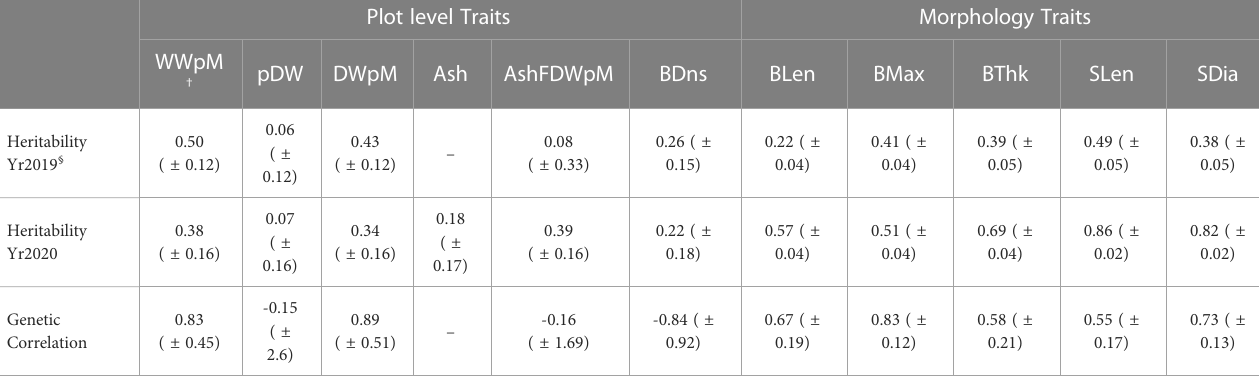
TABLE 1 Heritability across two years and genetic correlation between years for ten different